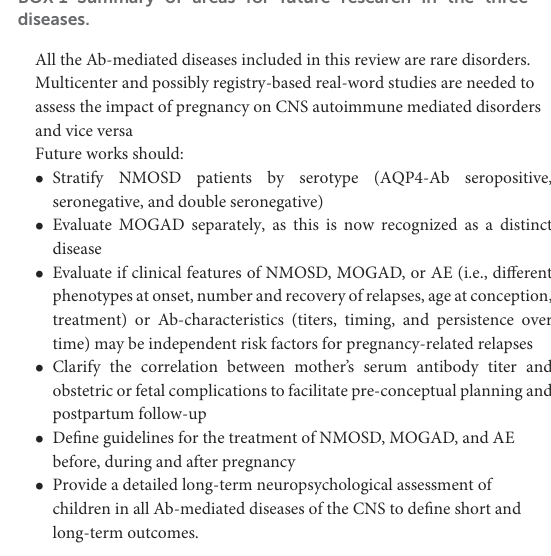
used in NMOSD during pregnancy need to be specifically evaluated